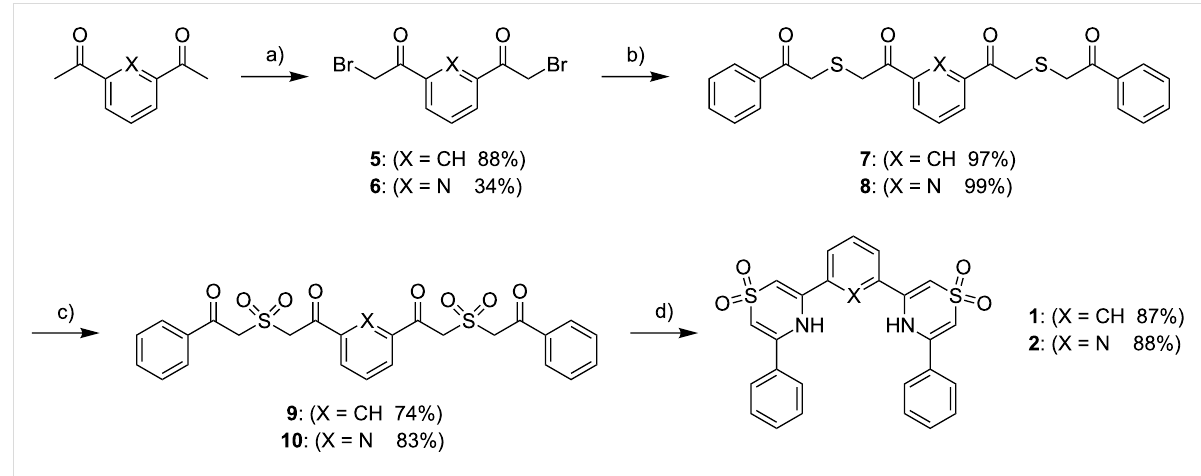
The three receptors were each titrated in acetone- d 6 with a number of TBA (tetrabutylammonium) salts of common